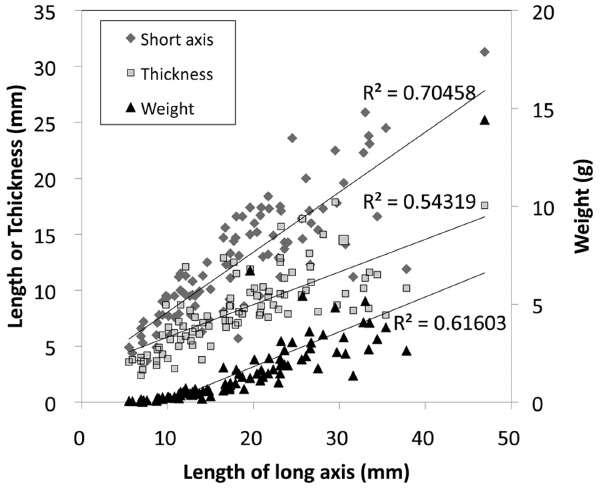
Figure 3. Size (long and short axes, thickness) and mass distribution of